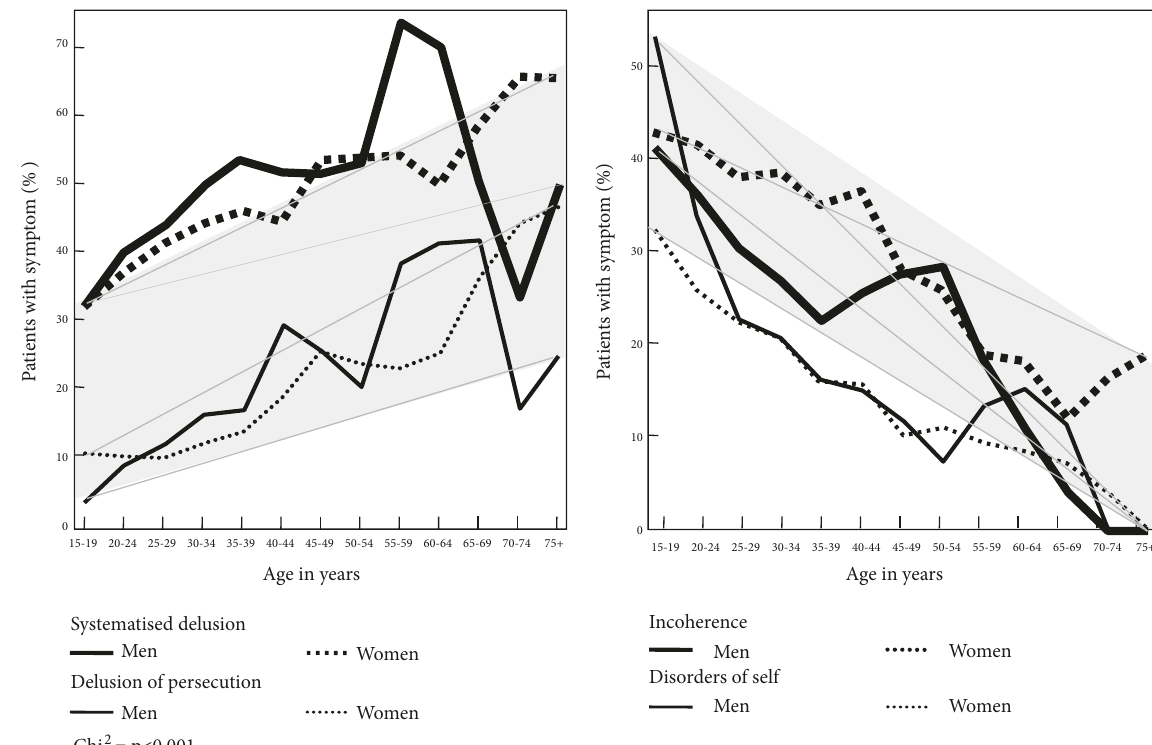
Figure 6: Psychotic symptoms showing significant age trends; based on data from CIMH (N=1,109) (CIMH: Central Institute of Mental Health) . Source: